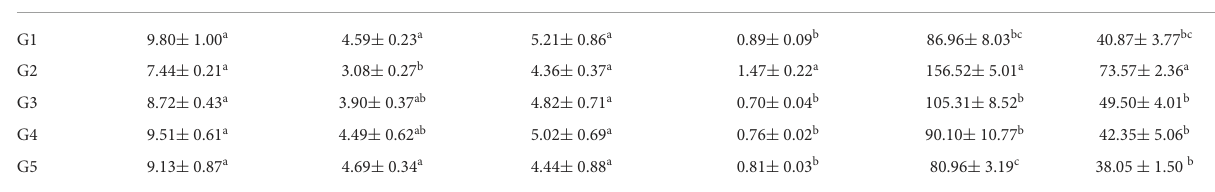
TABLE 5 Effect of hydroalcoholic extract of L. culinaris sprouts on kidneys’ functions in CCl 4 -induced oxidative stress and hepatotoxicity in rats (mean ± SE), n = 8. Group Kidneys’ functions